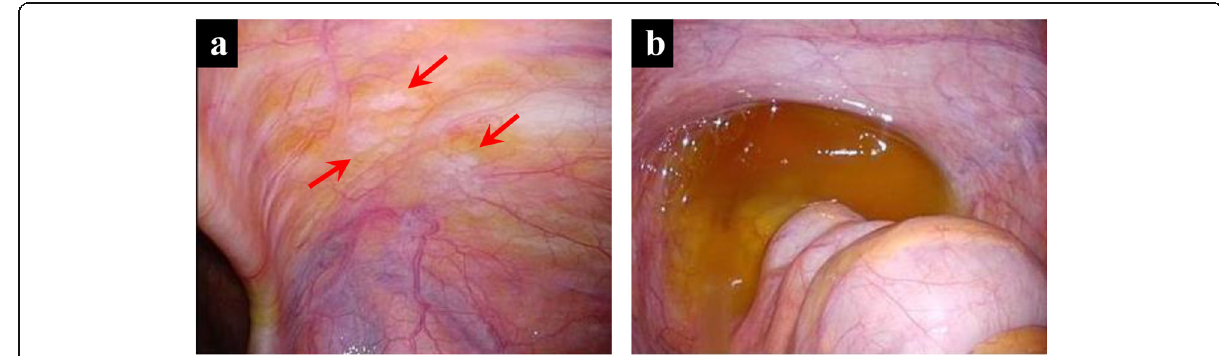
Fig. 2 Staging laparoscopy images. a Disseminated white nodules on the right lower abdominal wall (arrow). b Moderate ascites in the rectovesical pouch